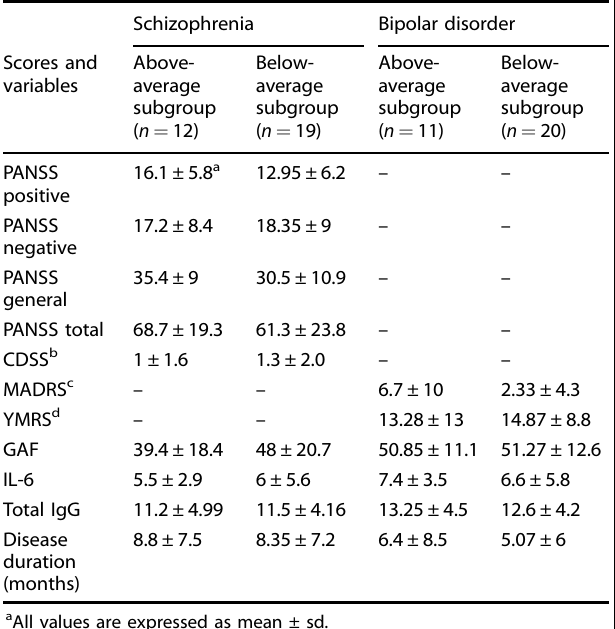
Table 3. Subgroup division based on DNA hydrolysis distribution.